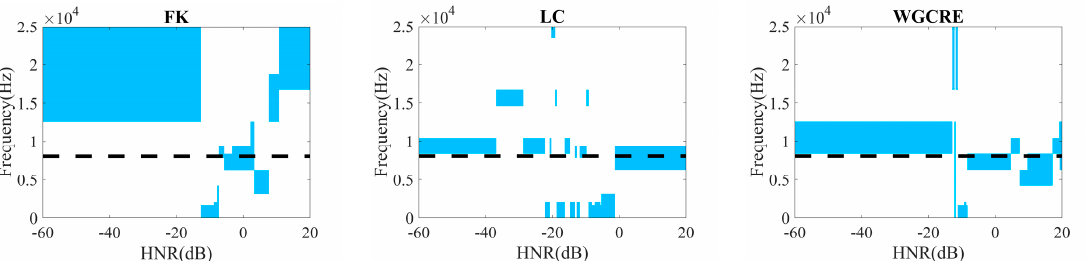
Figure 5. Selected optimal demodulation bands under Gaussian white noise for different HNR.